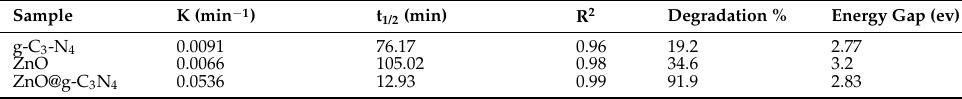
Table 1. Kinetics parameters of MB dye degradation.